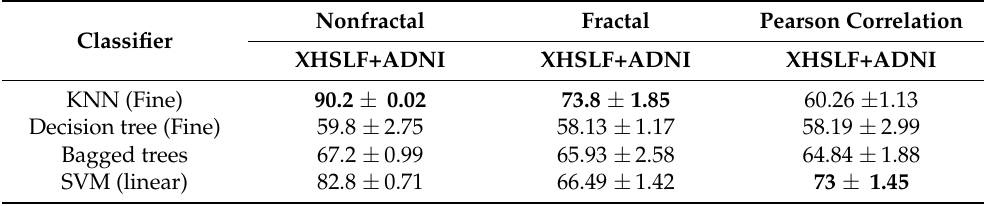
Table 6. 10-fold cross-validation classification accuracy (in %) of AD vs. NC using k-nearest neigh- bor (KNN), decision tree, bagged trees and SVM for XHSLF+ADNI dataset, which had a total of 122 subjects.